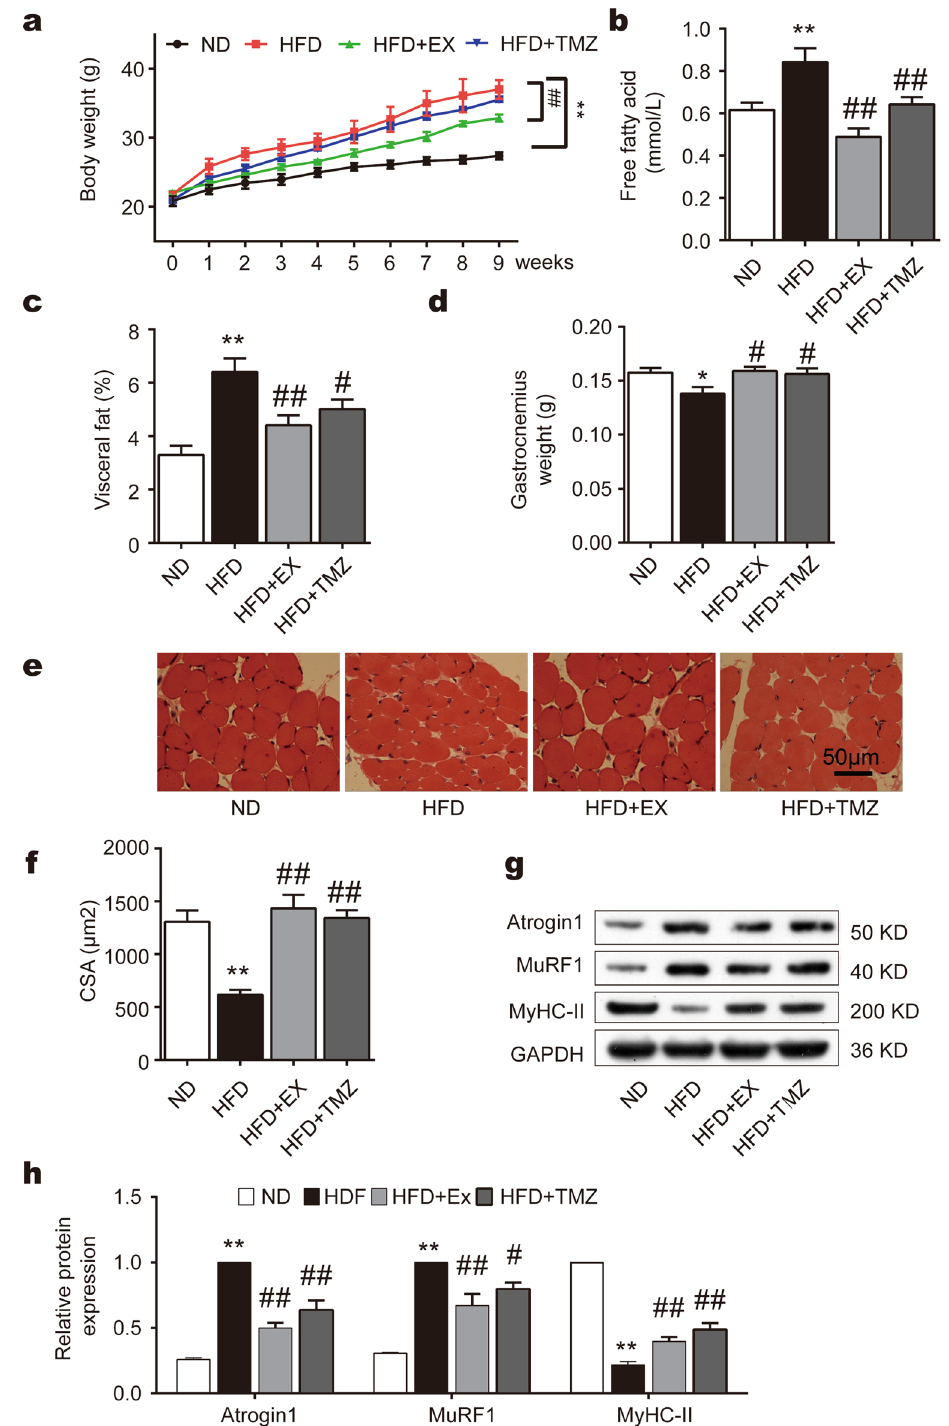
Figure 3. TMZ prevents metabolic dysfunction and muscle atrophy in mice following high-fat diet feeding similarly to exercise. ( a ) Body weights of normal diet-group (ND), high-fat diet-group (HFD), high-fat diet + exercise-group (HFD + Ex), and high-fat diet + trimetazidine-group (HFD + TMZ) during eight weeks of intervention. ( b ) The concentration of free fatty acids (FFA) in fasting plasma. ( c ) Visceral fat was dissected and weighed. ( d ) Gastrocnemius muscle was dissected and weighed. ( e , f ) Hematein and eosin (HE) staining of skeletal muscle tissues. Muscle fiber cross-sectional area was calculated by the image analysis software. ( g , h ) MyHC-II, MuRF1, and Atrogin1 protein expression were determined by Western blot. *, ** represented p < 0.05, p < 0.01 in comparison with ND group, respectively; # , ## represented p < 0.05, p < 0.01 in comparison with HFD group,